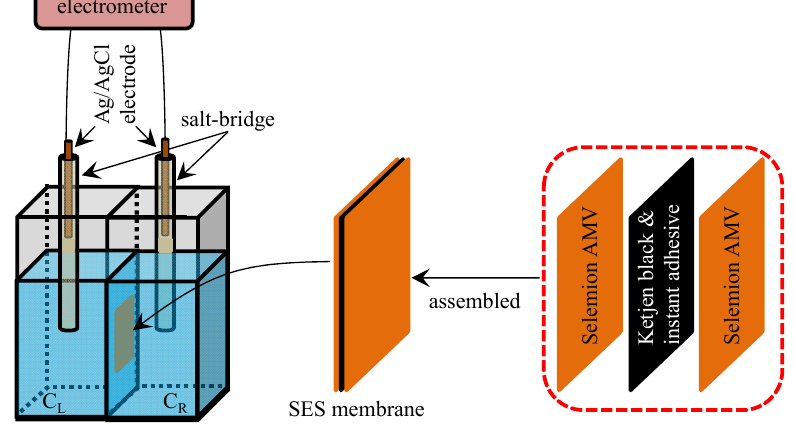
Figure 9. Structure of SES membrane and the experimental setup for measuring the potential across the SES